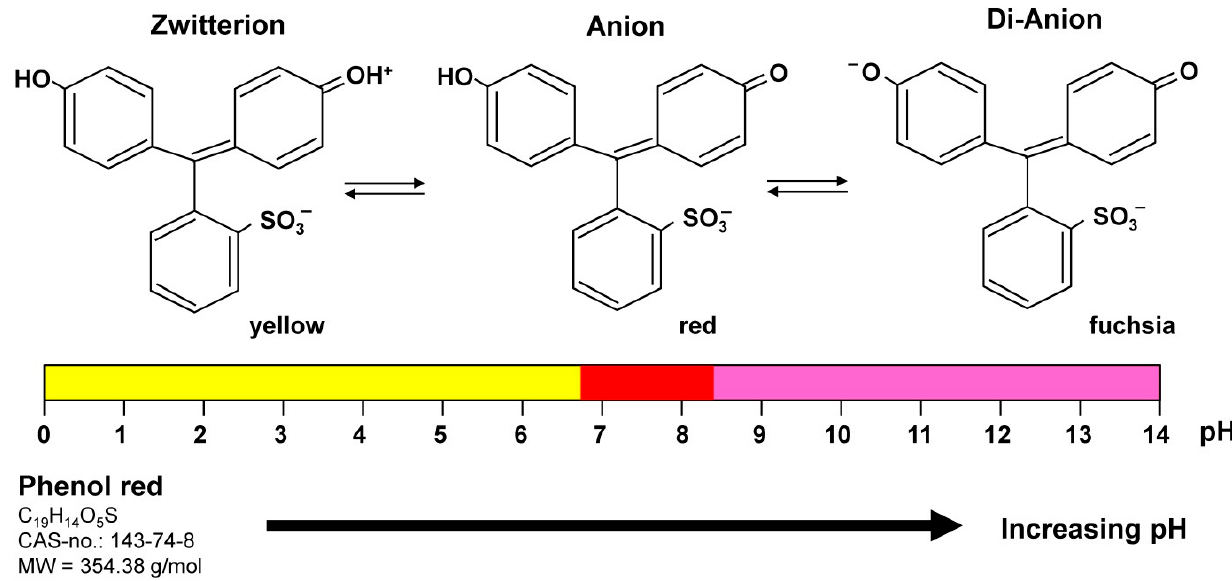
Figure 1. Monitoring pH changes in cell culture by phenol red. Phenol red (Phenolsulfonphthalein) is a triphenylmethane dye used in cell cultures to monitor pH changes. Its color exhibits a gradual transition from yellow to red and fuchsia with increasing pH.